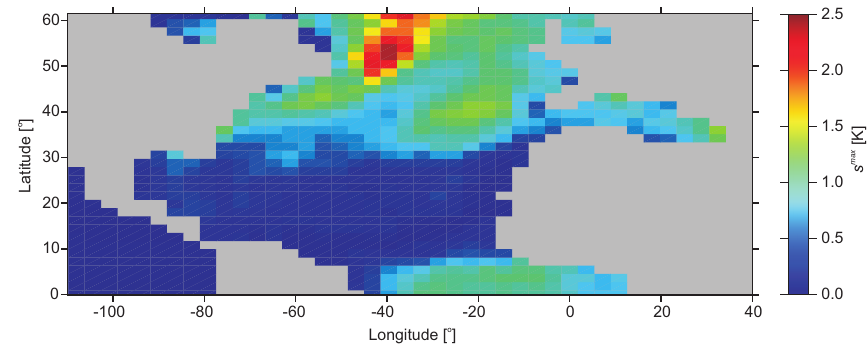
Fig. 4. The maximum allowable standard error of estimation, s max , in a calibrated SST proxy if the temperature variability attributable to the AMO is to be reconstructed with a SNR > 1. It is assumed that the temporal resolution of the proxy data is 1 year and the estimated values of s max represent the best case scenario. If the temporal resolution was decreased then s max would also